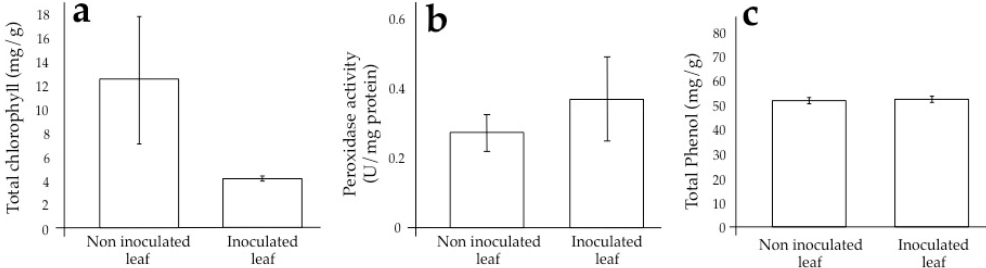
Figure 3. Alteration of biochemical properties in leaves of tested plants (PS 881 cultivar). ( a ) Total chlorophyll, ( b ) activity of peroxidase, and ( c ) total phenol accumulation. All data are estimated triplicates.